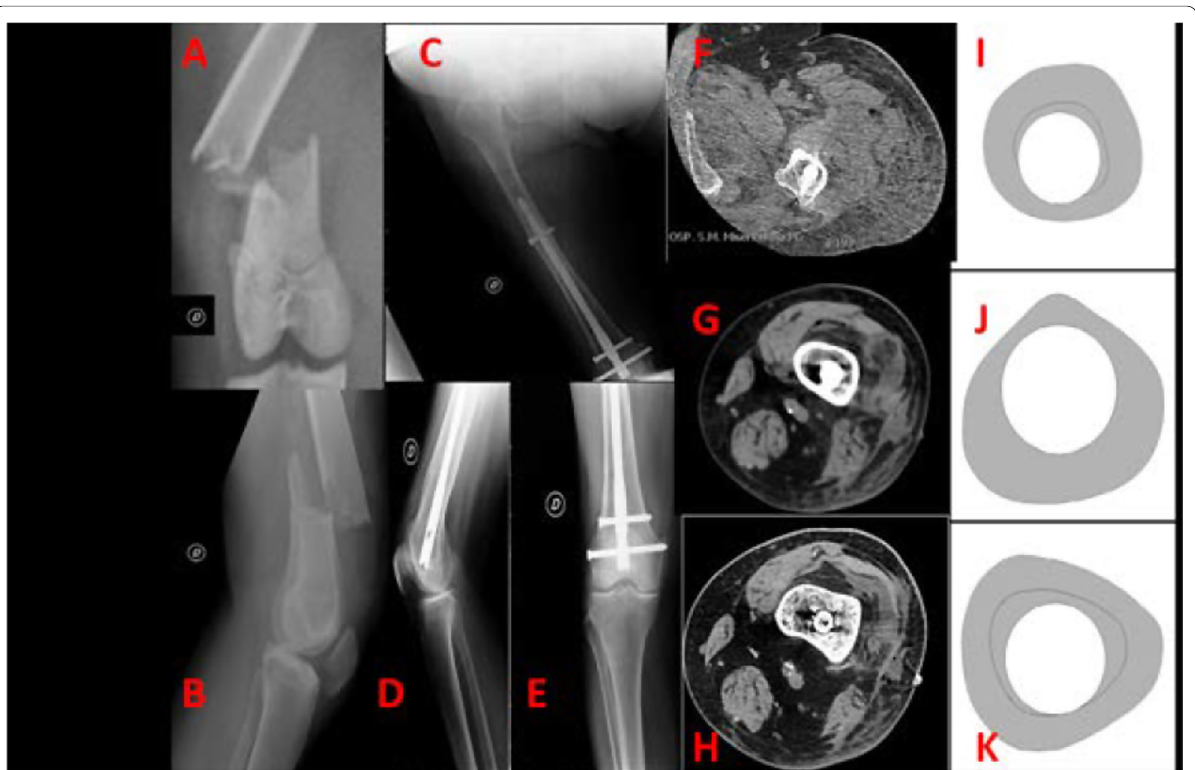
Fig. 2 47F, road car accident, 32 A3 type of fracture ( A , B ). X-ray at 12 months post-operation ( C – E ) showed satisfactory fracture healing after locking retrograde nail. Absence of stress shielding of the nail is shown in F – H comparing images with biomechanics representations ( I – K ) proposed by Shih et